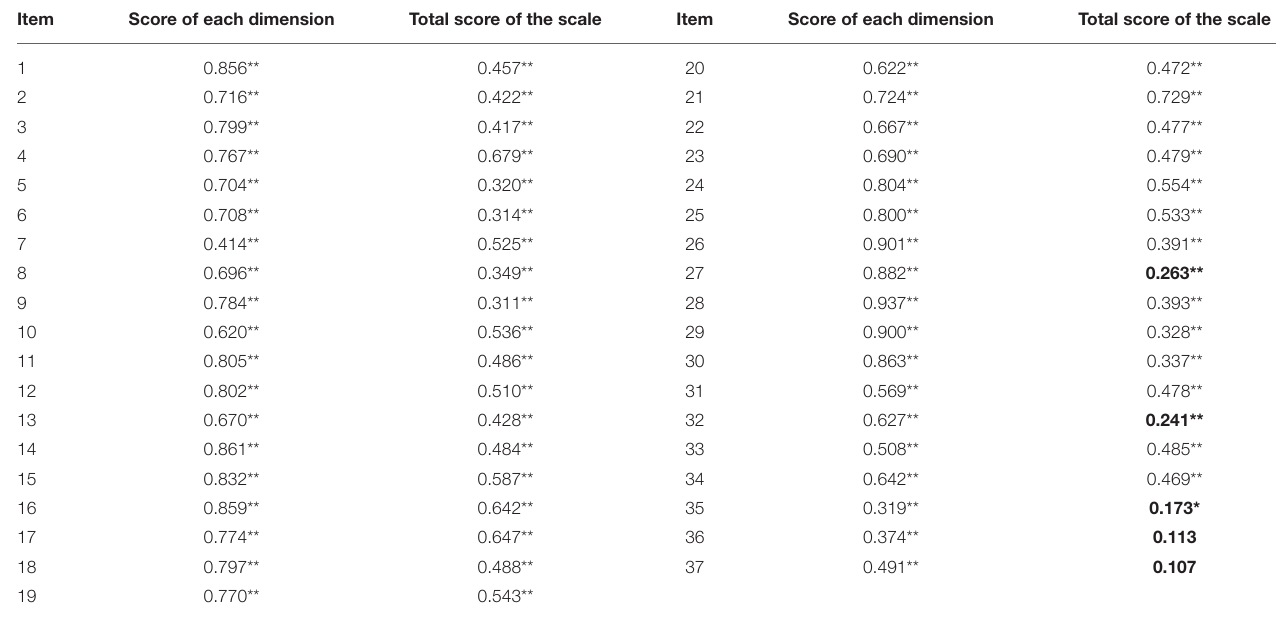
TABLE 4 | Relationship between entry and total score of each dimension and total score of the scale ( N = 185). Item Score of each